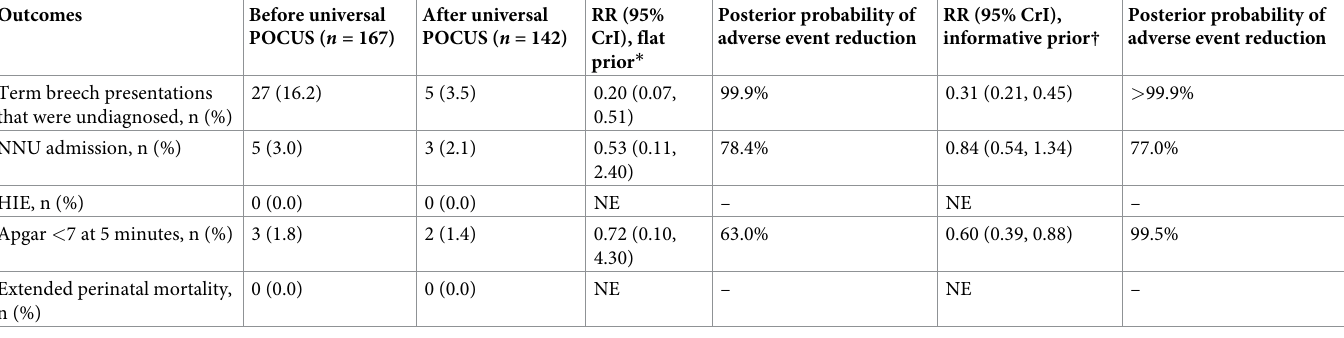
Table 4. Perinatal outcomes of breech presentations in the study epochs before and after the introduction of universal POCUS at 36 weeks in in Norfolk Norwich University